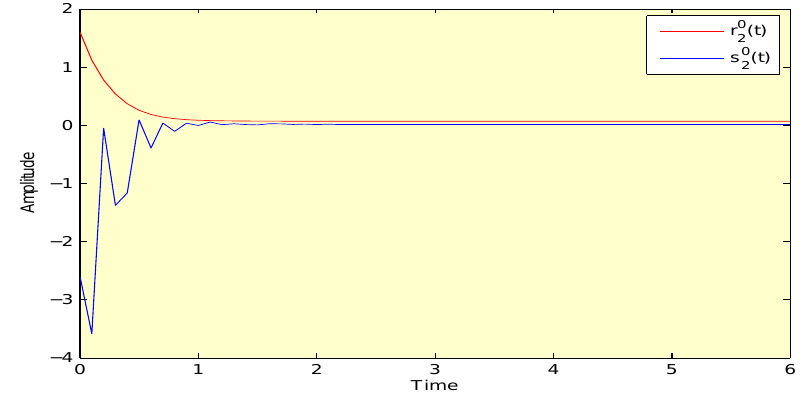
( t ) , (cid:115) 0 ( t ) of NN models (1) and (3). 2 2